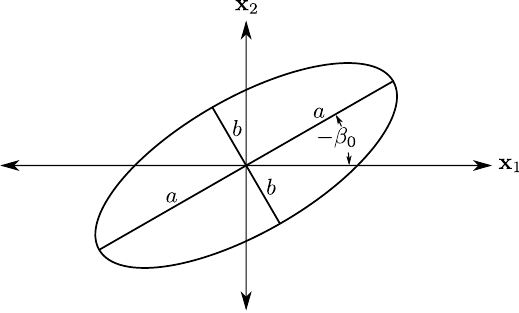
Figure 4. Features of measured ellipse.